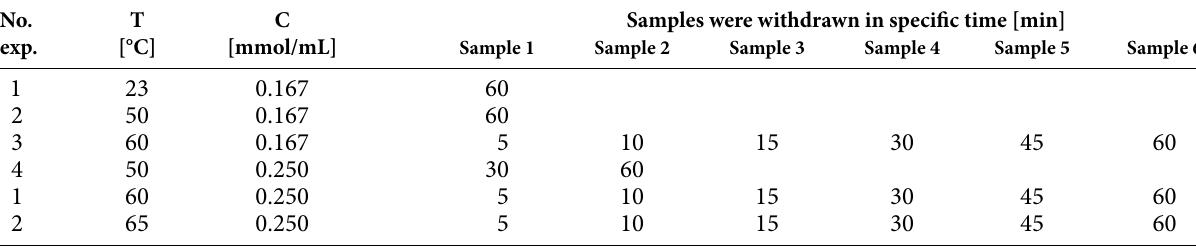
Table 1 . Temperature, concentration and sampling times at each experiment run. No. T C S amples were withdrawn in specific time [min]